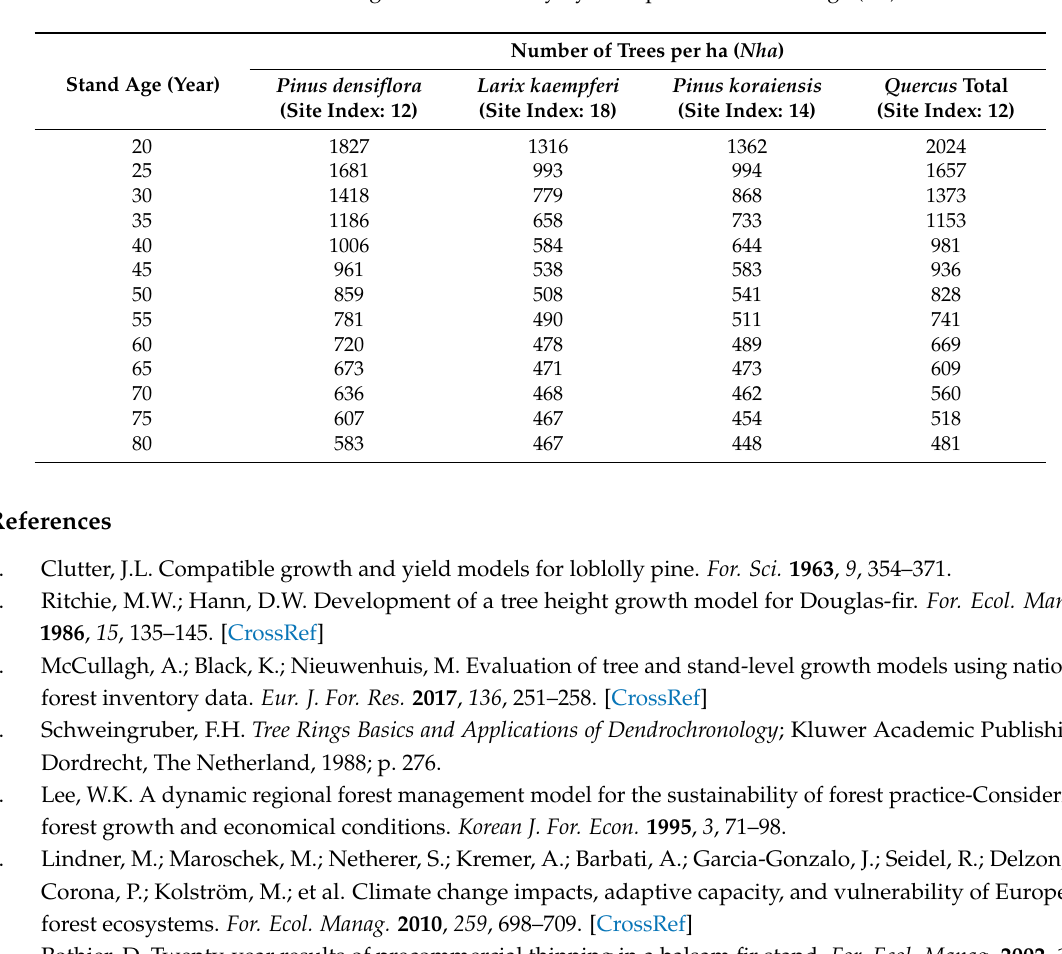
Table A1. The change of stand density by tree species and stand age